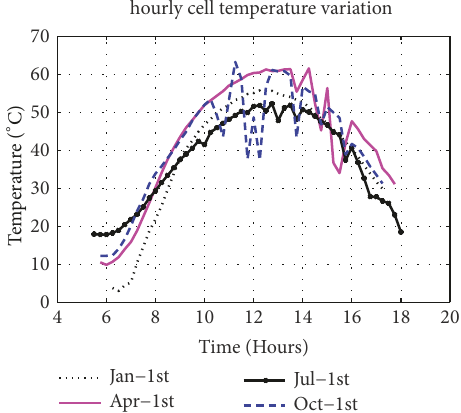
Figure 10: Hourly variation of global radiation on optimally tilted panel.